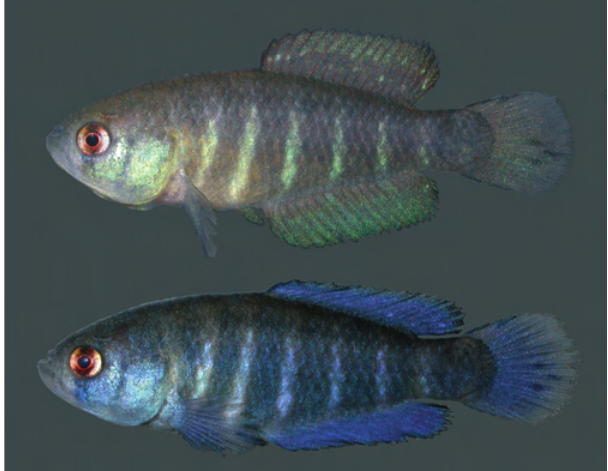
Fig. 2. Austrolebias paucisquama , paratype, MCP 41880, male 25.5 mm SL, Rio Grande do Sul, São Sepé, temporary pool close to BR290 highway (30°22’27”S, 53°33’42”W), rio Vacacaí drainage. Same specimen alive (above) and just after fixation in formalin